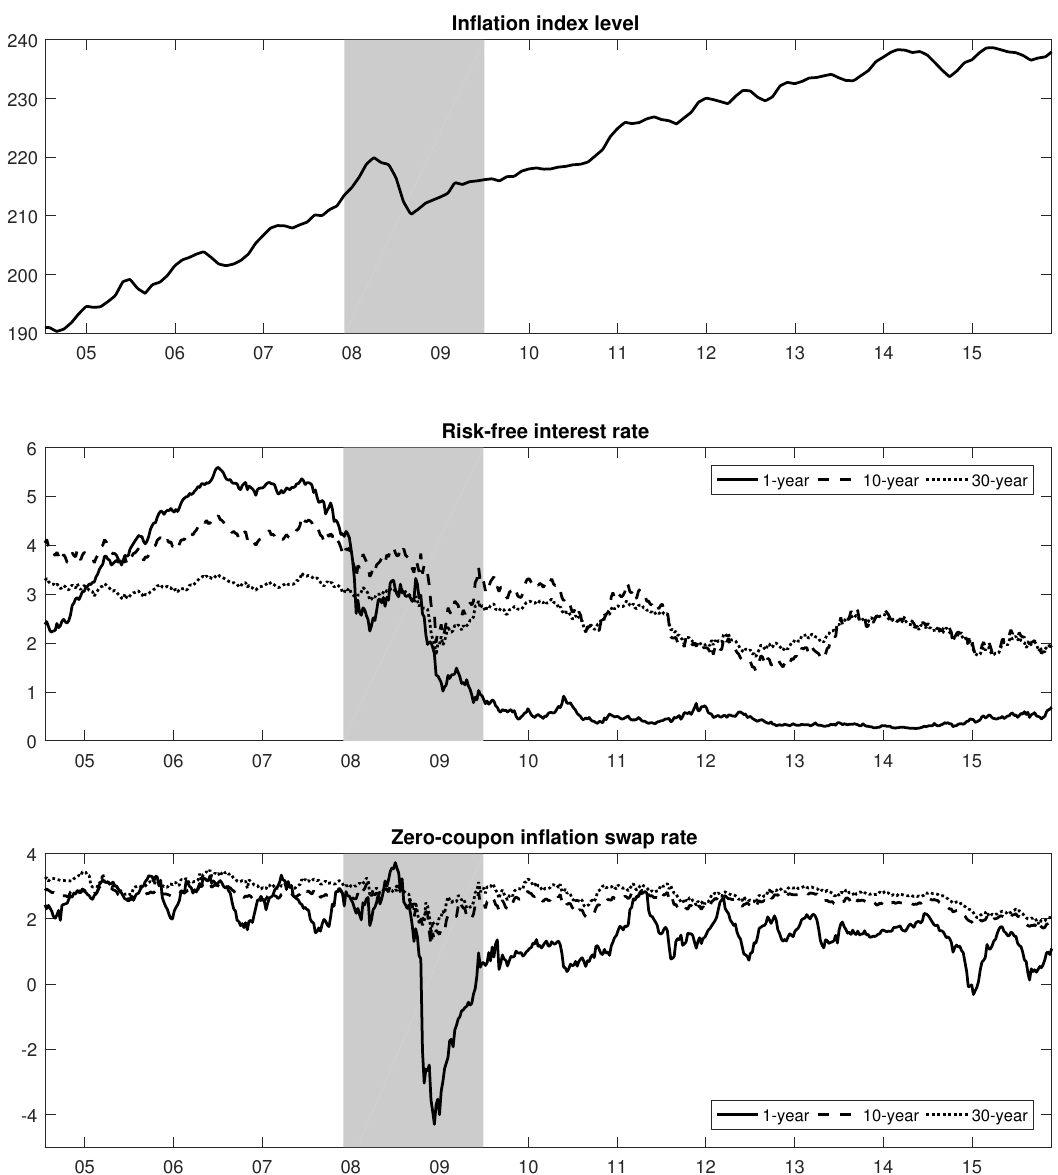
Figure 1. Evolution of the inflation index level I , the risk-free interest rate for maturities of 1, 10, and 30 years in percentages, and the zero-coupon inflation swap rate for maturities of 1, 10, and 30 years in percentages. The inflation index level is defined as the three-month lagged linearly interpolated value of the Consumer Price Index for All Urban Consumers (CPI-U). The CPI-U level is collected via Federal Reserve Economic Data (FRED) from April 2004 to March 2016. The risk-free interest rate is proxied by both London Interbank Offered Rate (LIBOR) rates (for maturities less than 1 year) and swap rates (for maturities greater or equal to 1 year). The LIBOR and interest swap rates are collected via FRED from July 2004 to December 2015. The zero-coupon inflation swap rate is defined as f = T the swap price and T is the maturity in years. The inflation swap rates are collected via the Bloomberg system from July 2004 to December 2015. The grey-shaded region highlights the National Bureau of Economic Research (NBER)-dated